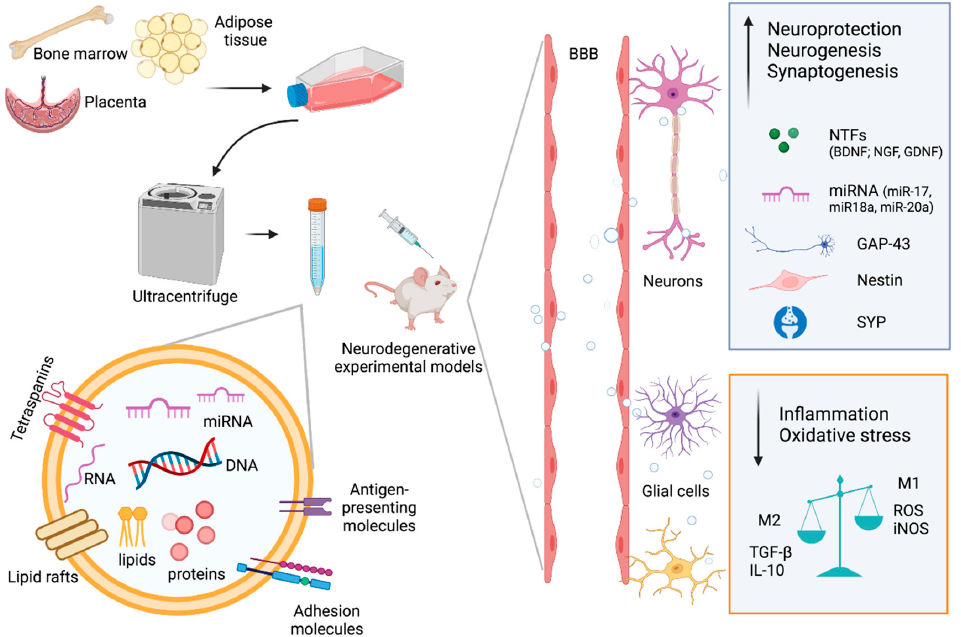
Figure 1. Extracellular vesicles from mesenchymal stem cells as an innovative therapy for neurodegenerative